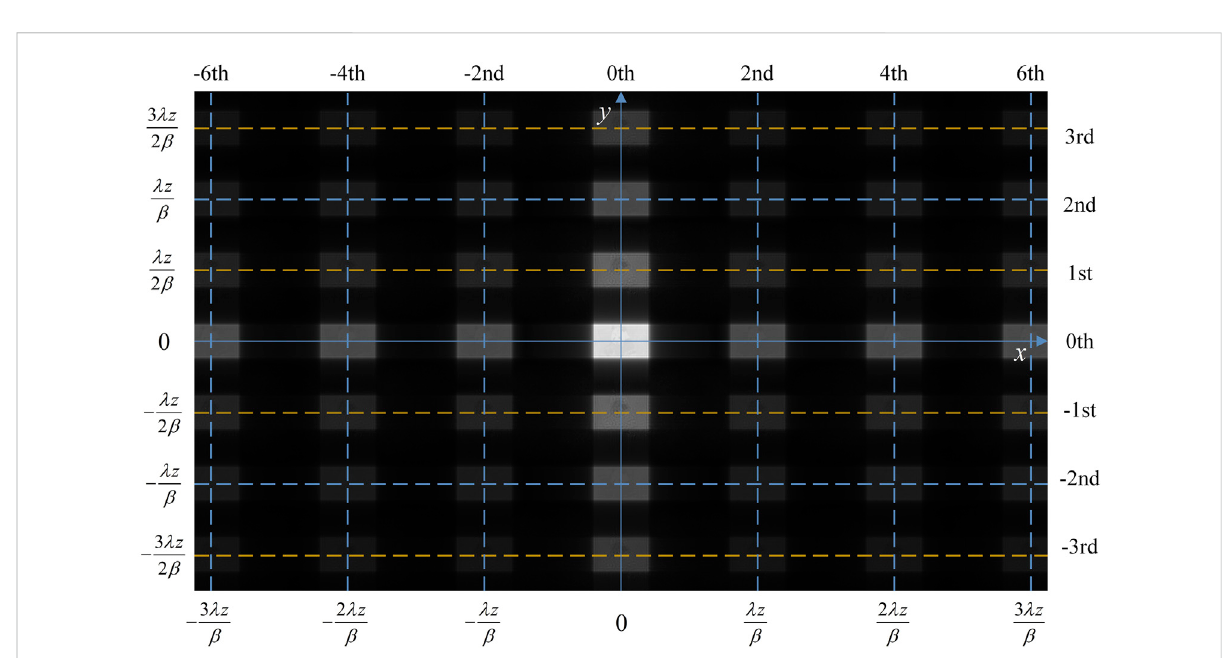
FIGURE 6 Diffraction pattern of phase-only holograms with the strip-like encoding method in y -axis